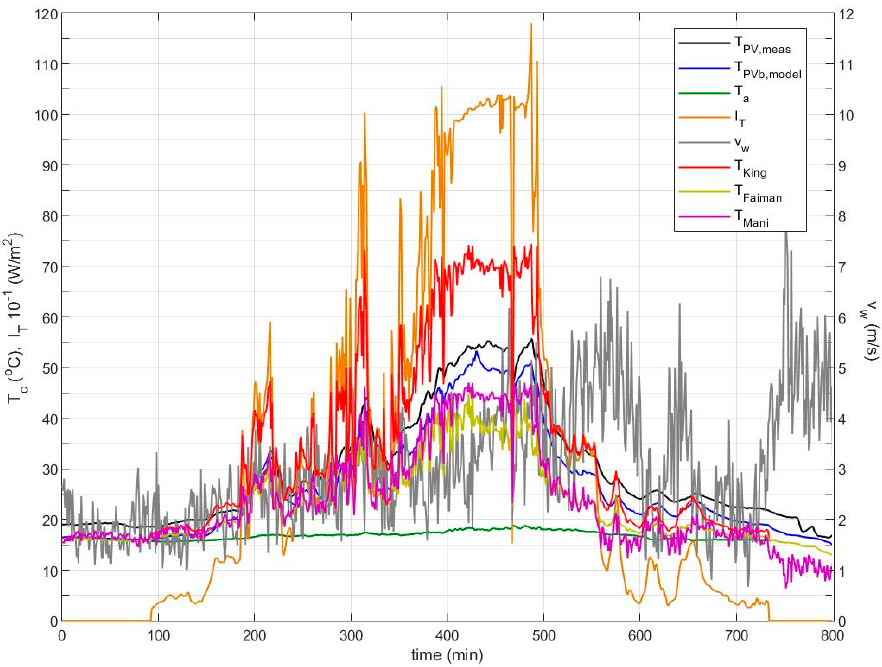
Figure 7. As in Figure 4, during an overcast day in April, with interval 1 min.